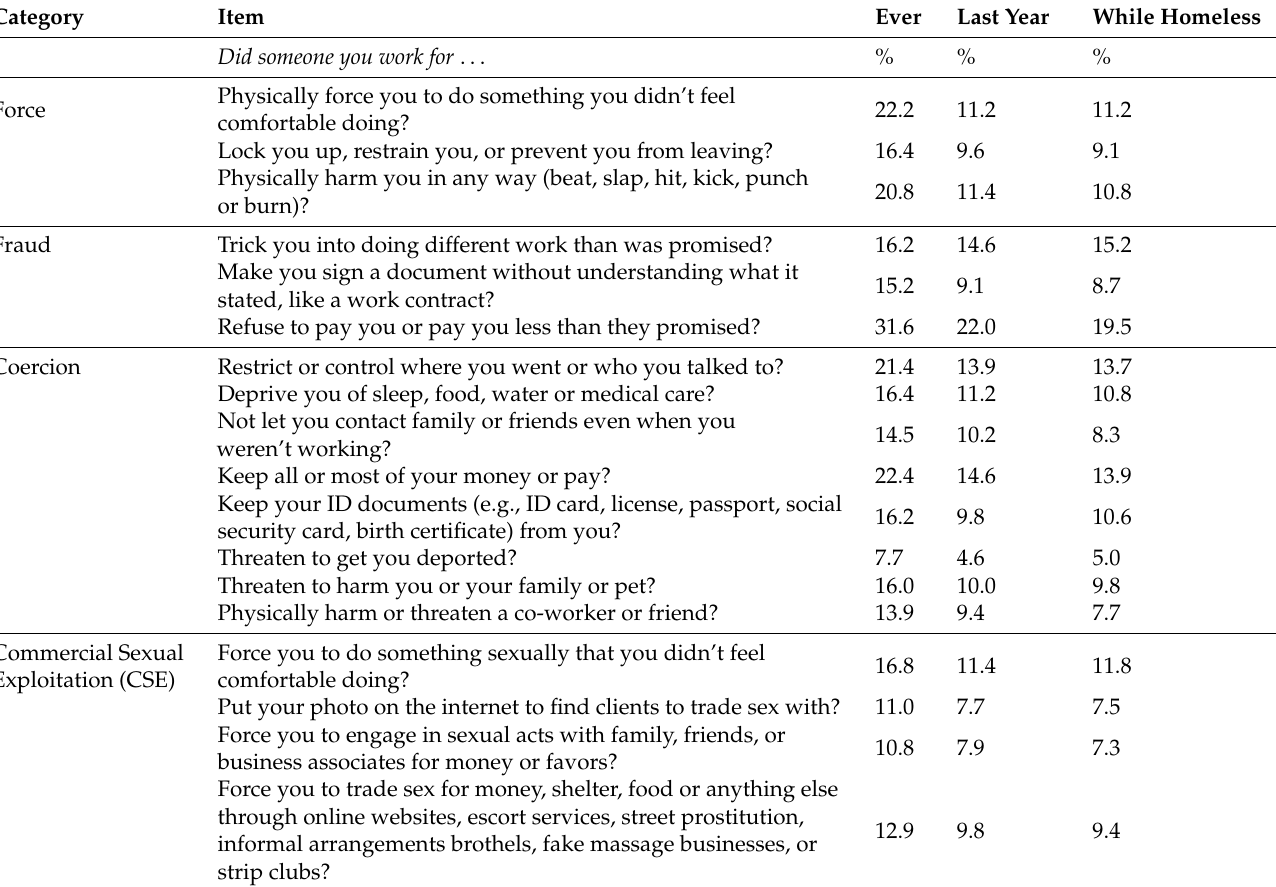
Table 3. Number and percentage of youth who responded affirmatively to the Human Trafficking Screening Tool (HTST), 2018 Atlanta Youth Count (n = 519).